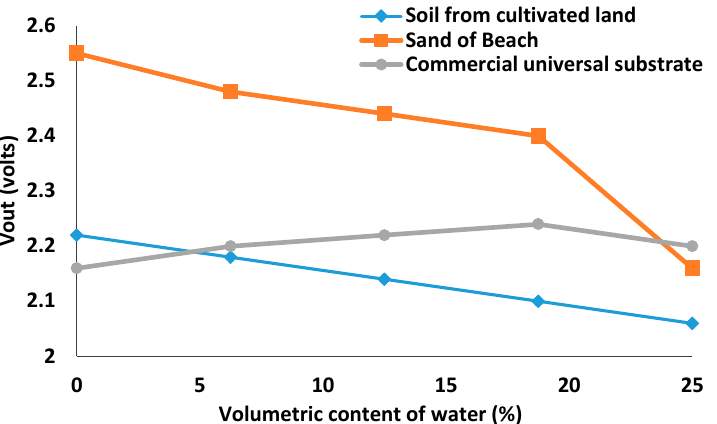
Figure 7. Behavior for prototype 1 in several types of soils.